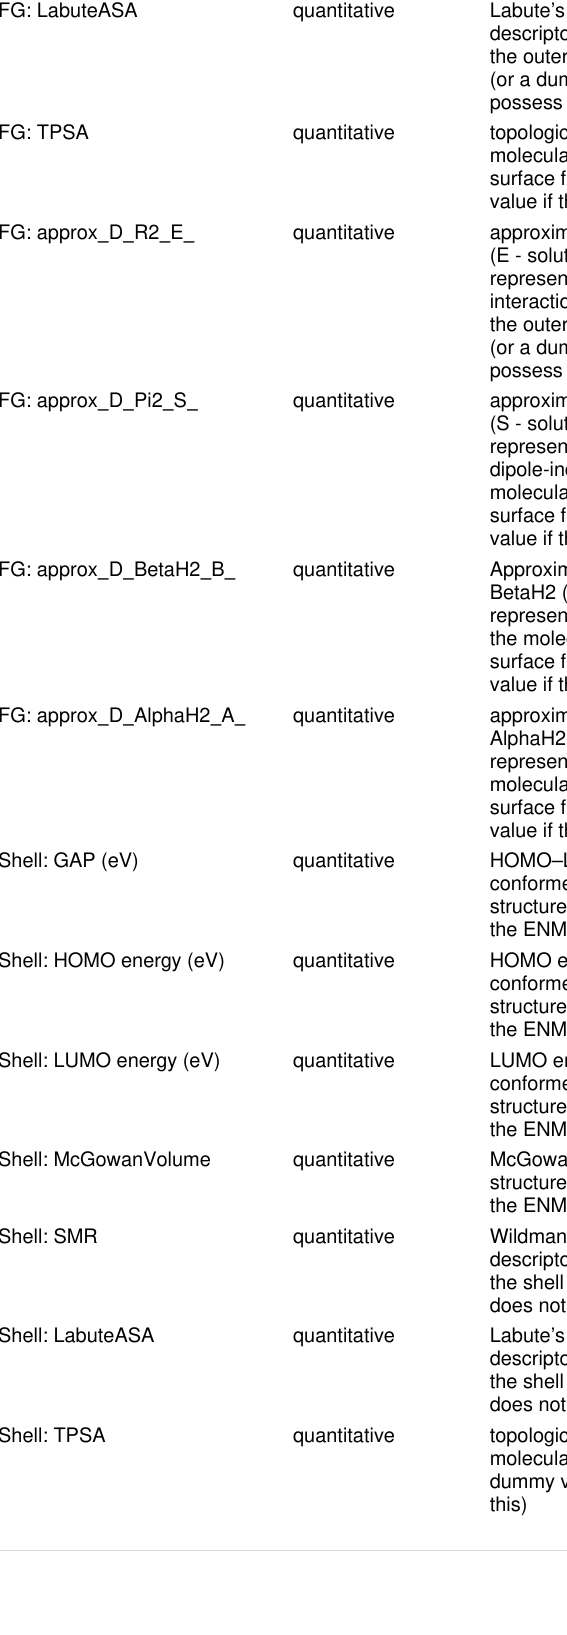
Table 3: Summary of all descriptor names, or prefixes for the one-hot-key encoded qualitative variables, reported in Supporting Information File 2, along with a description of how they were derived. (continued) FG: